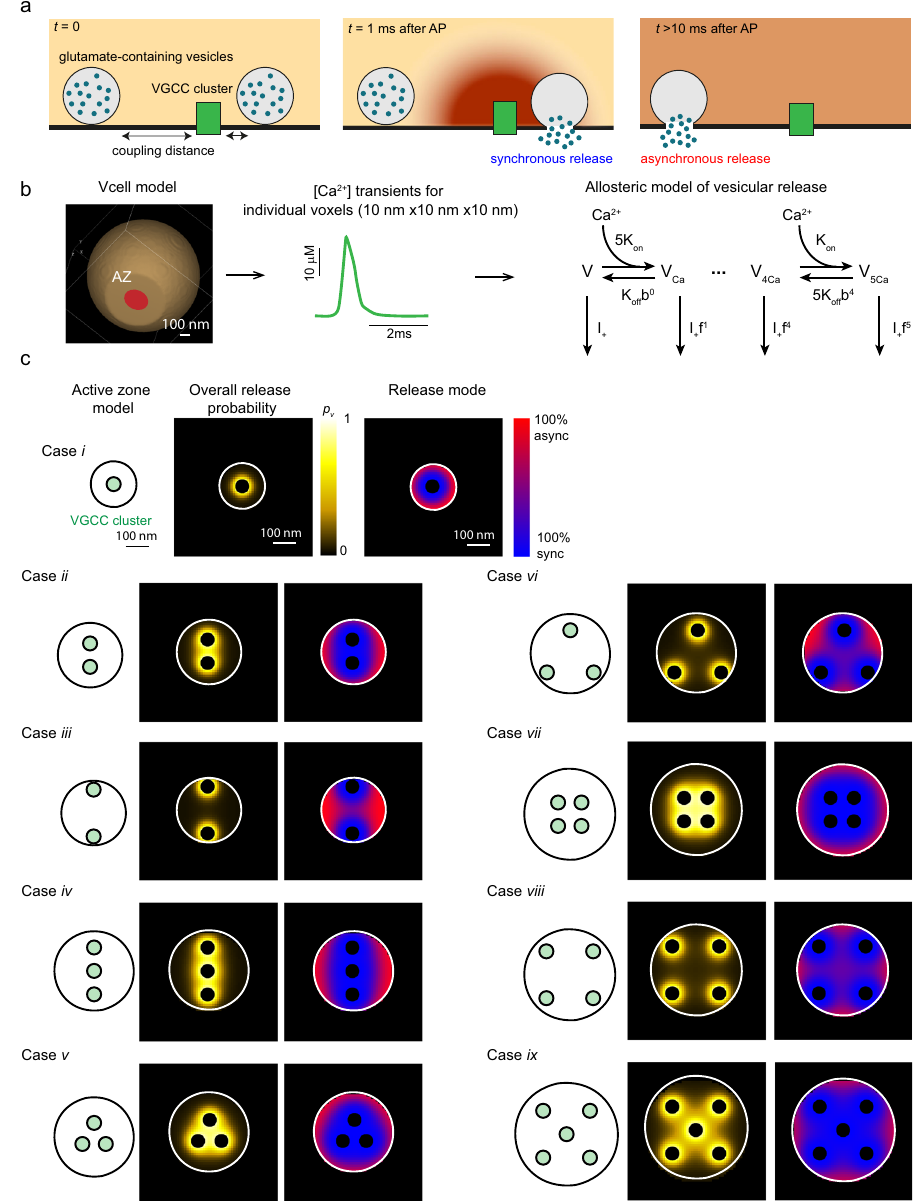
Fig. 7 Modelling of synchronous and asynchronous release – generation of release probability maps for different active zone geometries. a Schematics illustrating Ca 2 + triggering of different release modes. Synchronous release occurs within several milliseconds after an action potential and is triggered by transient local Ca 2 + -nano/microdomains (~10 – 100 µ M range) in the close vicinity of activated VGCCs (2 – 100 nm range). In contrast, asynchronous release occurs on a time scale of tens to hundreds of milliseconds and is triggered by longer-lasting global changes in presynaptic Ca 2 + concentration (~1-5 µ M range) 1, 30 . b Schematics of the modelling framework. Action potential-evoked Ca 2 + dynamics in a presynaptic bouton (left) were simulated using the VCell computational environment on a 10 x 10 x 10 nm mesh (Methods). For each voxel located in the active zone, the obtained Ca 2 + transients (middle) were used as an input into the allosteric model of Ca 2 + activation of vesicular fusion 42 (right) to compute the probability of synchronous release for individual RRP vesicles p s . As discussed in the text, the probability of asynchronous release p a was assumed not to depend on the vesicle location in the active zone and its value was constrained based on the experimental data (Methods). c Nine cases of considered active zone geometries ( i to ix ) and corresponding model- predicted maps of the overall release probability p v ¼ p s þ ð 1 (cid:2) p s Þ p a , and of the relative fractions of synchronous (blue) and asynchronous (red) release modes for the model with endogenous buffering (see also Supplementary Fig. 13 for the model with the intracellular pipette ¼ p þ ð 1 (cid:2) p Þ p overall release probability of RRP vesicles p with endogenous buffers (calmodulin, Calbindin D28k and ATP) v s s a (Fig. 7c) and a bouton fi lled with the intracellular pipette buffer and for the relative contribution of each release mode at different (EGTA, ATP, K + -gluconate) (Supplementary Fig. 13) (Methods active zone locations (Fig. 7b). As the recorded cells were and Supplementary Tables 1 and 2). stimulated in the whole-cell patch-clamp mode (which leads to gradual replacement of the endogenous buffers with the pipette solution), we considered two limiting cases: a presynaptic bouton